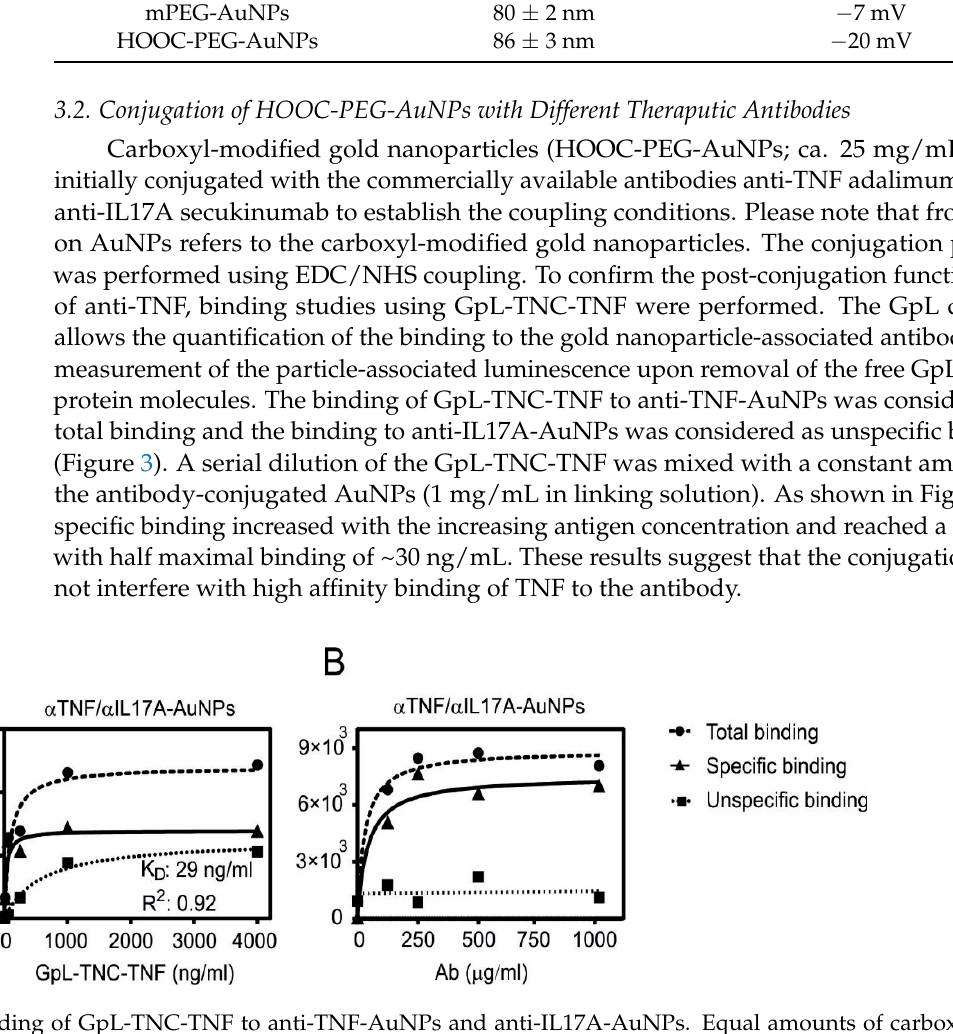
Figure 2. DLS size distributions of colloidal AuNPs unPEGylated (left) and after PEGylation with carboxyl-PEG-SH (center) and mPEG-SH (right) . Three reads were performed using the DLS device, and the SD of the results were as follows: AuNPs unPEGylated (0 nm), after PEGylation with